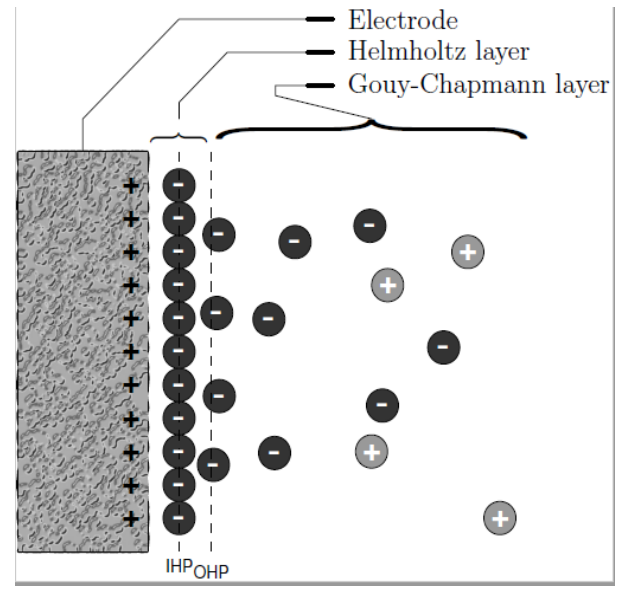
Figure 3. Distribution of charges as described by Gouy–Chapman.